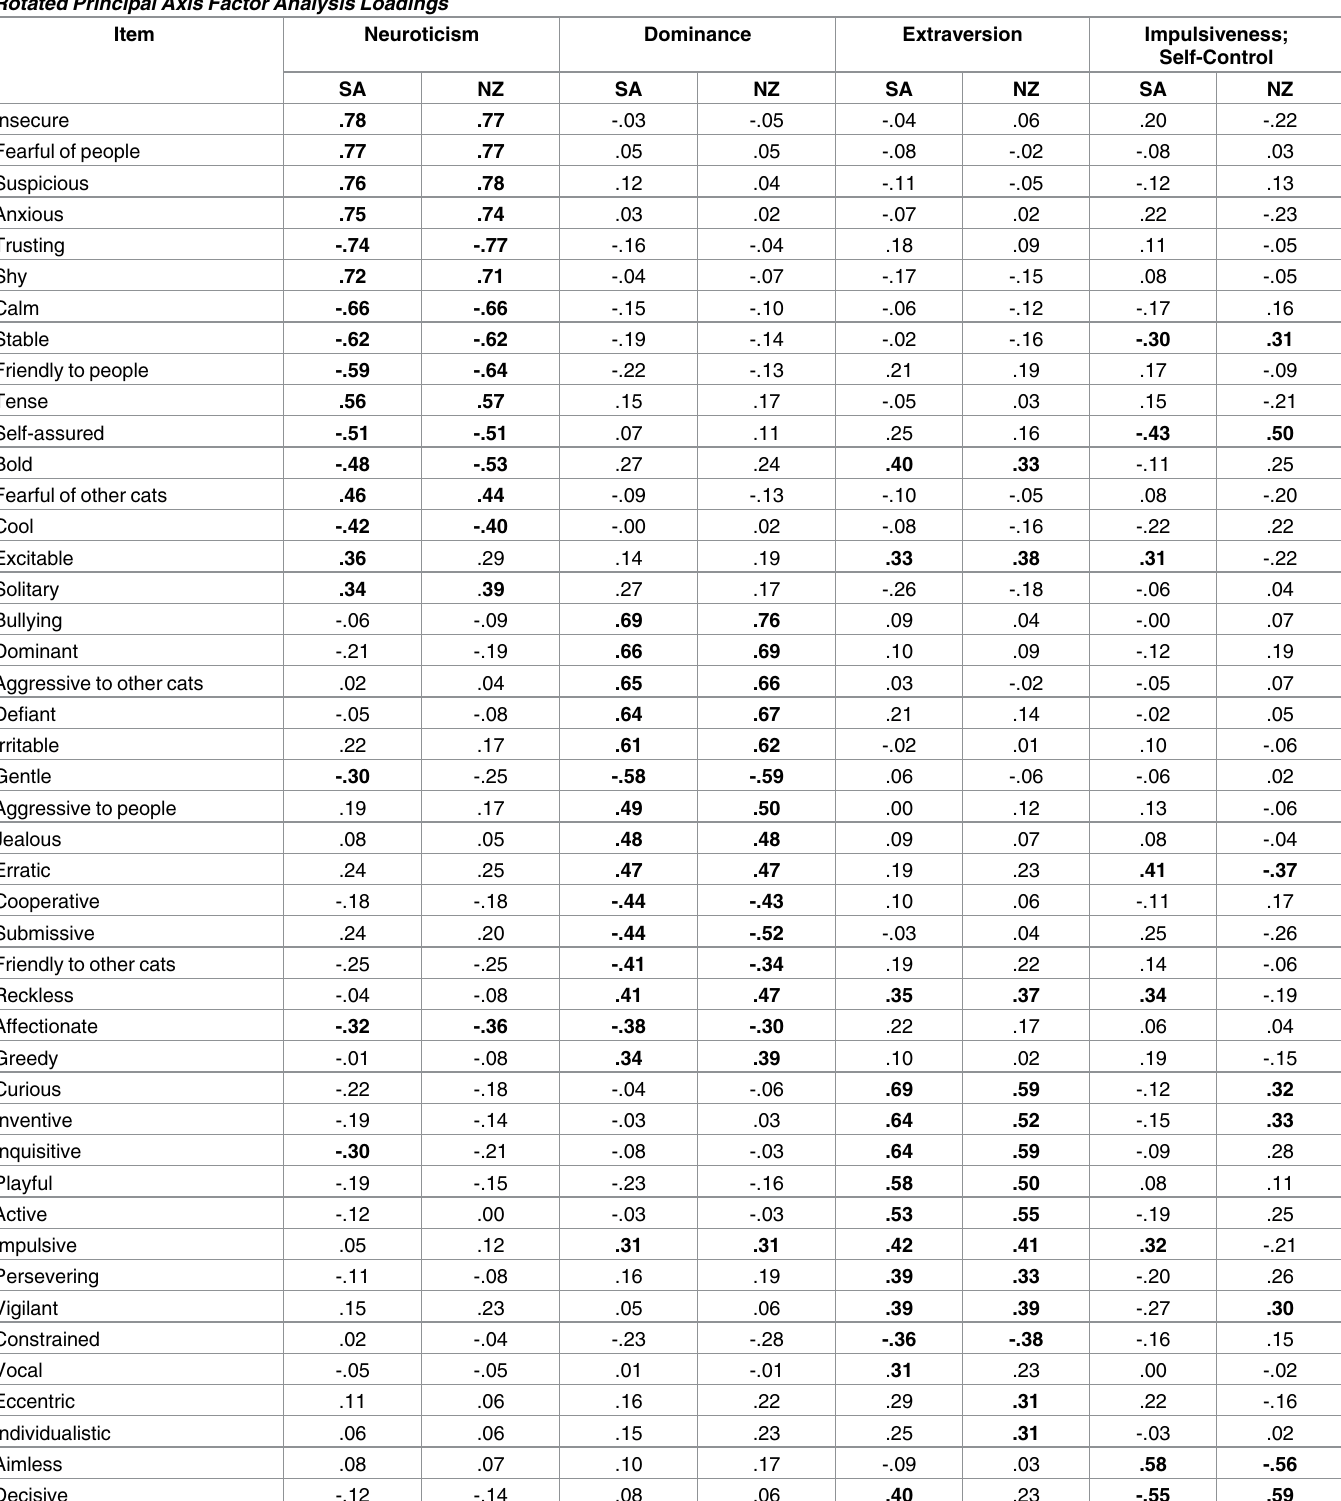
Table 1. Cross-validation of the cat personality measurement scale using two independent samples: South Australia (SA; n = 1,687) and New Zea- land (NZ; n = 1,115). Rotated Principal Axis Factor Analysis